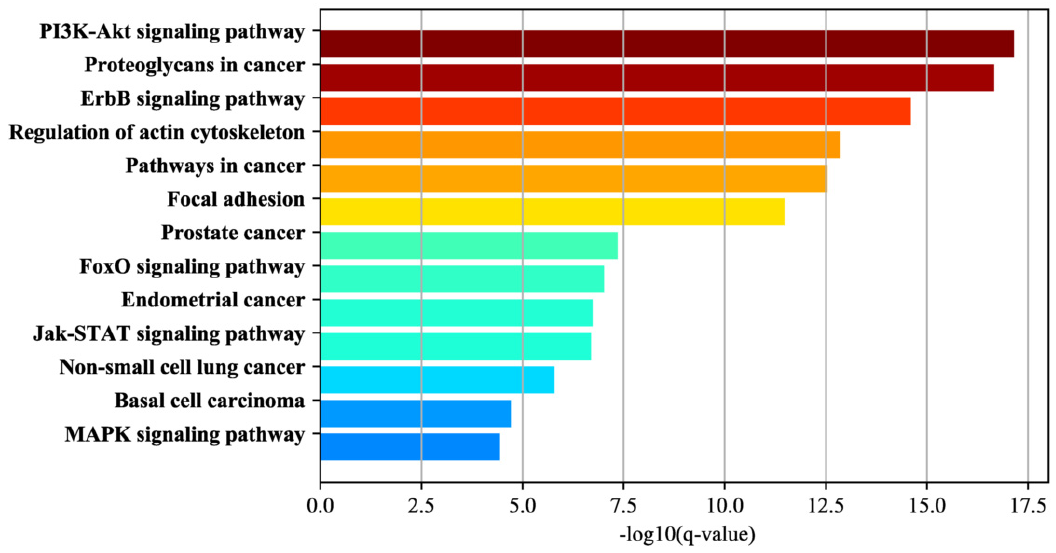
Figure 3. Functional annotation of the module genes.